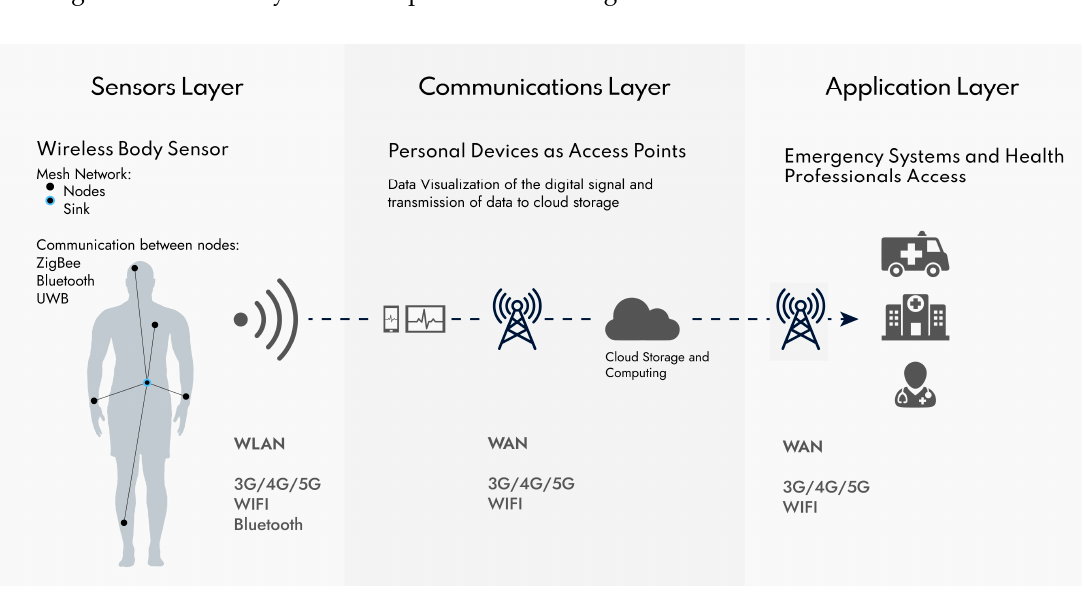
Figure 2. General implementation of an IoMT system for wireless patient monitoring and domiciliary hospitalization.